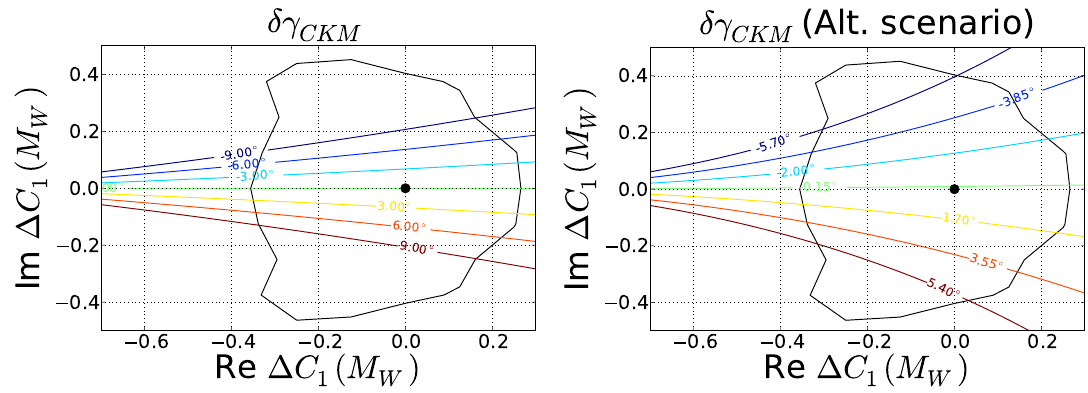
Figure 23 . Possible deviations on the CKM phase (cid:13) due to NP at tree level in C 1 ( M W ) assuming r A = 0 : 4 (left) and r A = 0 : 8 (right). In both cases we have considered r 0 corresponds to the SM